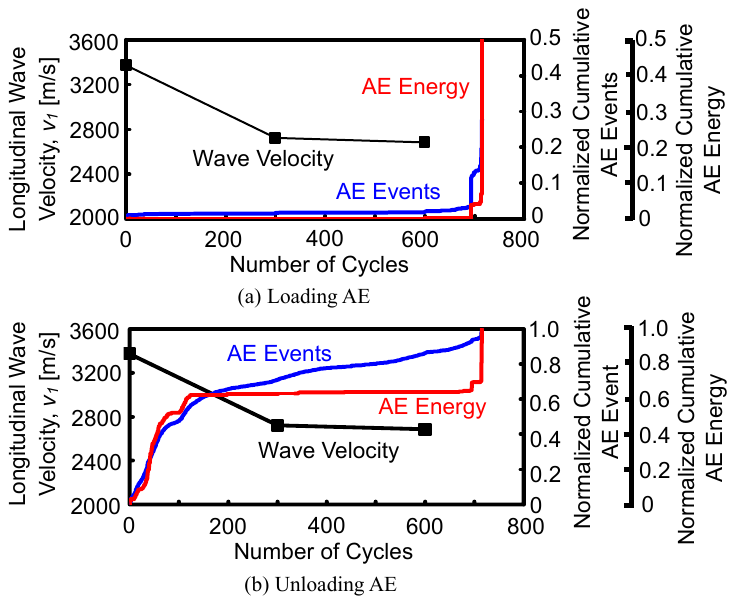
Fig. 9. Cumulative AE events and energy and ultrasonic wave velocity during cyclic compression test.